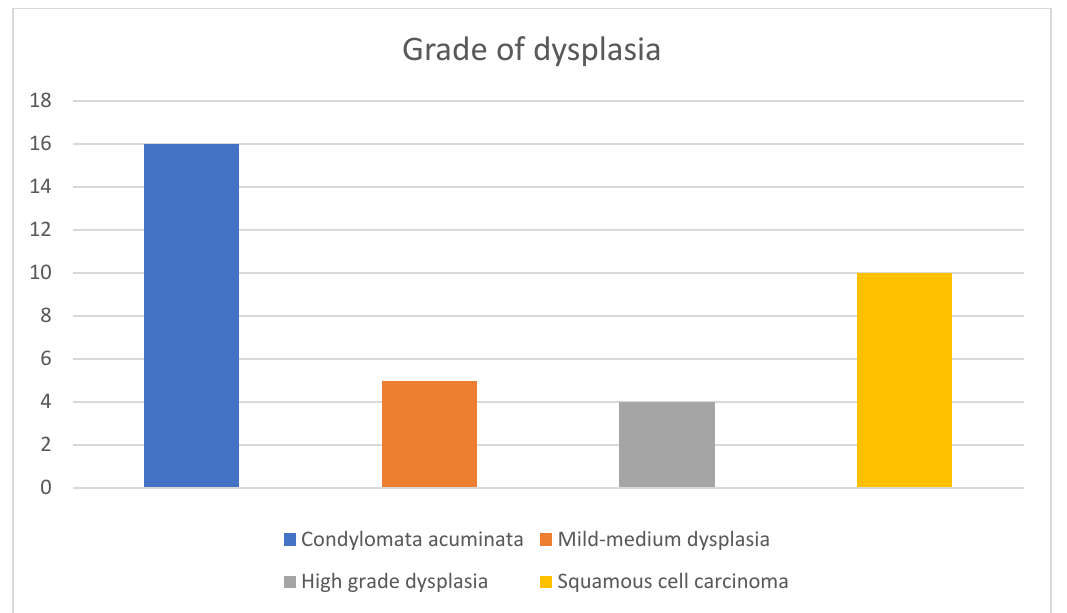
Figure 6. Grades of dysplasia in the histopathology results of the cohort, ranging from CA without dysplastic/neoplastic features to invasive SCC. A total of 19 patients (54.7%) had dysplastic and malignant features in their samples ranging from mild (5 patients) and high (4 patients) grade dys- plasia to confirmed SCC (10 patients), illustrating the prevalence of malignant transformation in the context of CA and the importance of follow up.